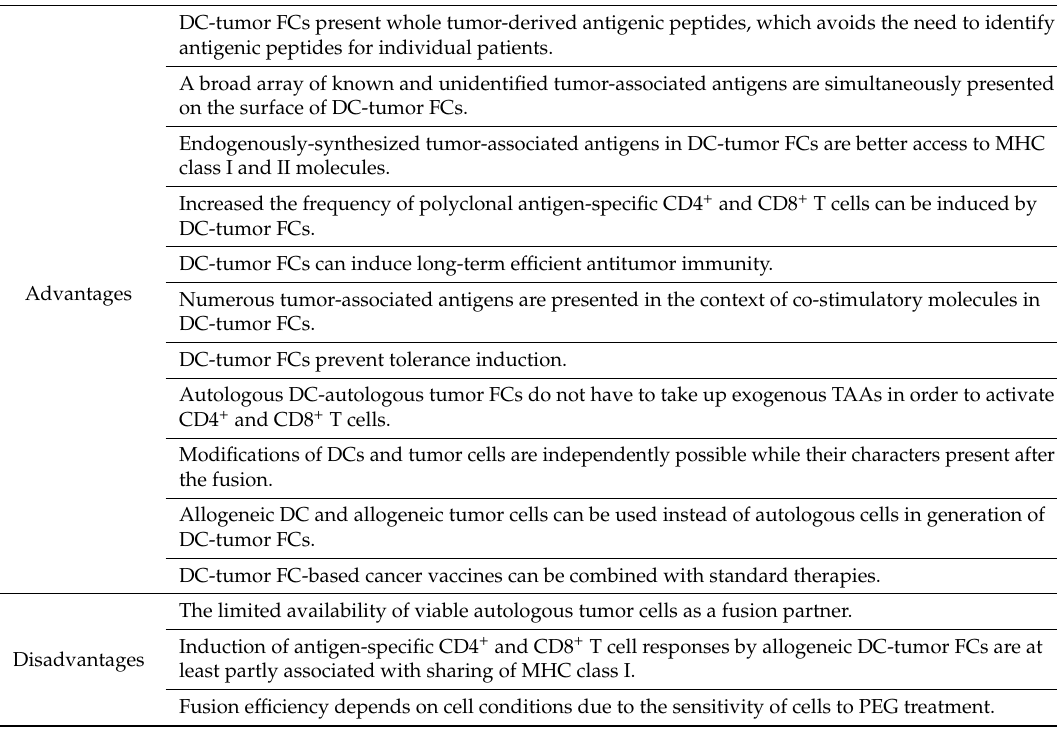
Table 1. Advantages and disadvantages of DC-tumor